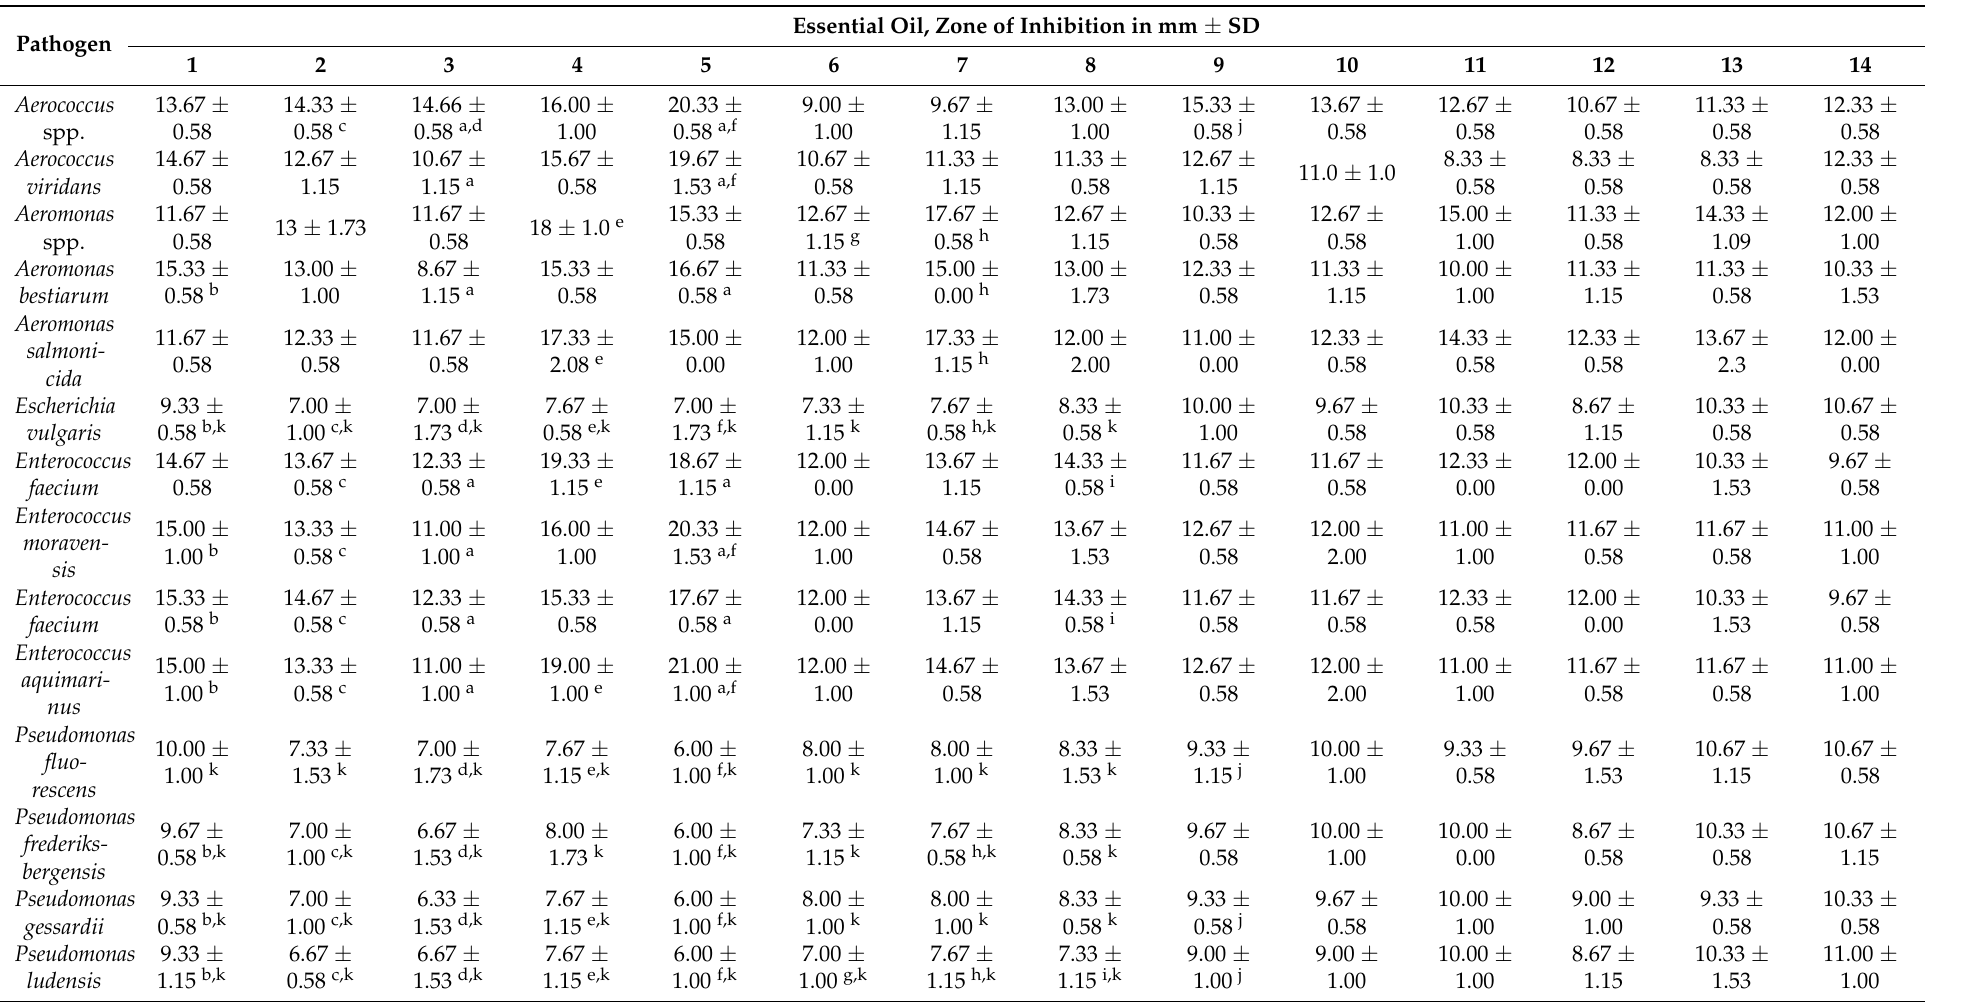
Table 3. Antimicrobial activity of essential oils with the disc diffusion